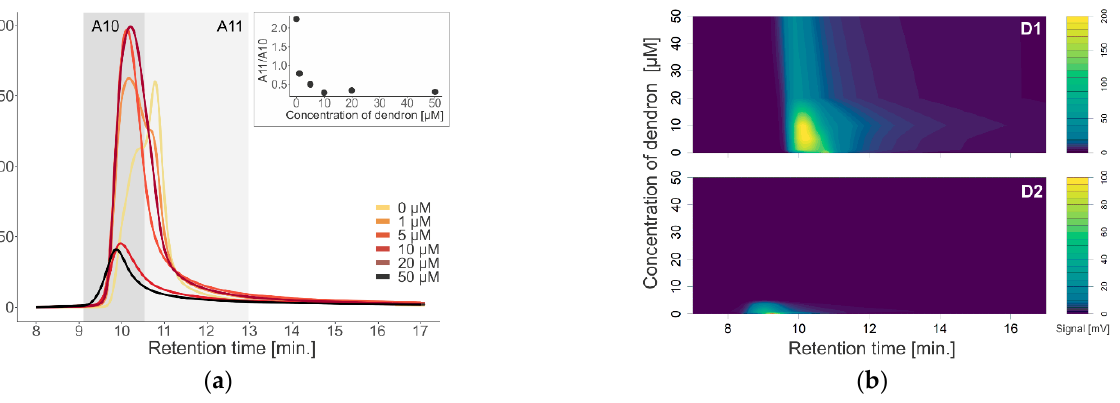
Figure 2. ( a ) Absorption chromatogram of liposomes with different dendron concentrations (0, 1, 5, 10, 20, and 50 µM). Nested graph shows ratio between peak areas at maximum absorption signal at 10 and 11 Minutes. ( b ) Contour plots of liposome absorbance at different dendron concentrations, top—first-generation dendron; bottom—second-generation dendron.